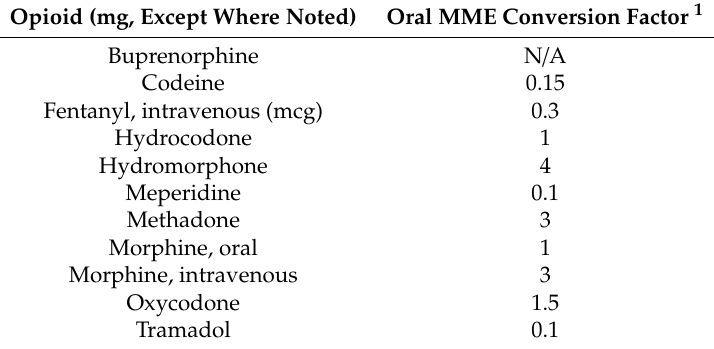
Table 1. Oral morphine milligram equivalents (MME) conversion